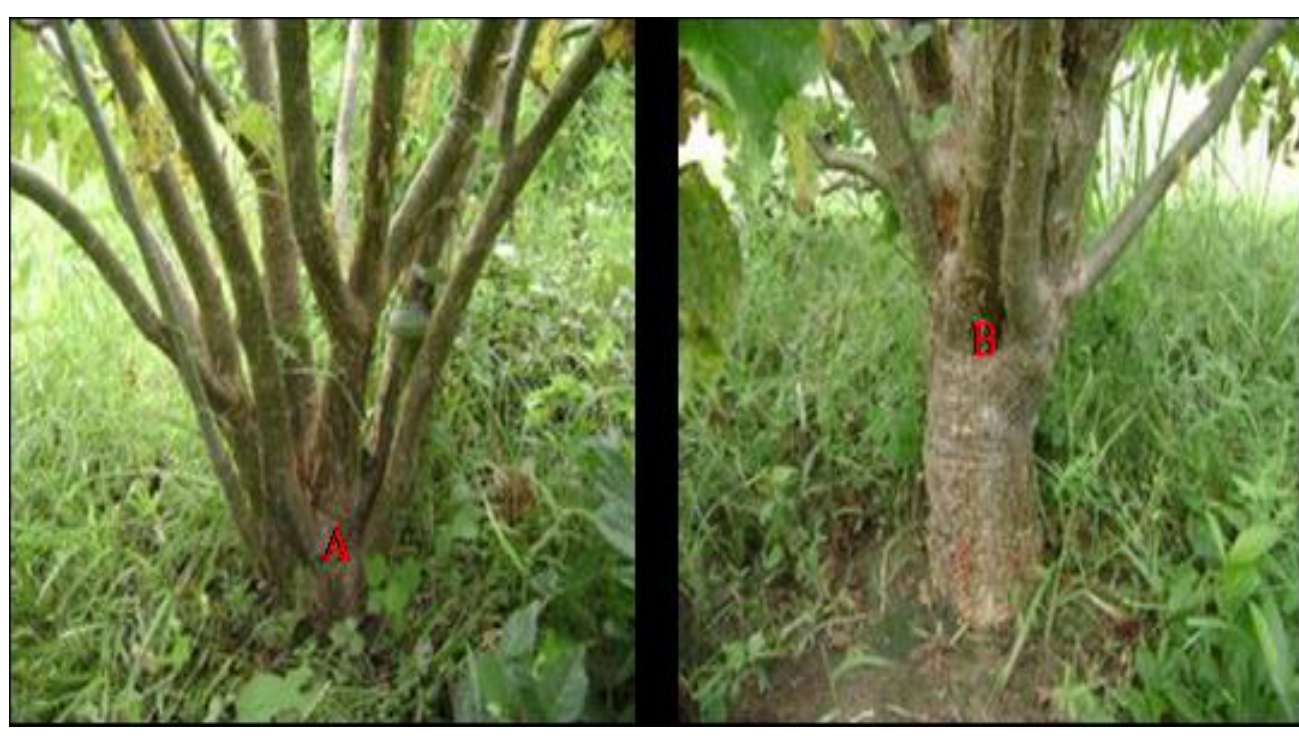
Figure 1. Branching pattern of J. curcas . A : Basal (70%), B : Intermediate (30%).